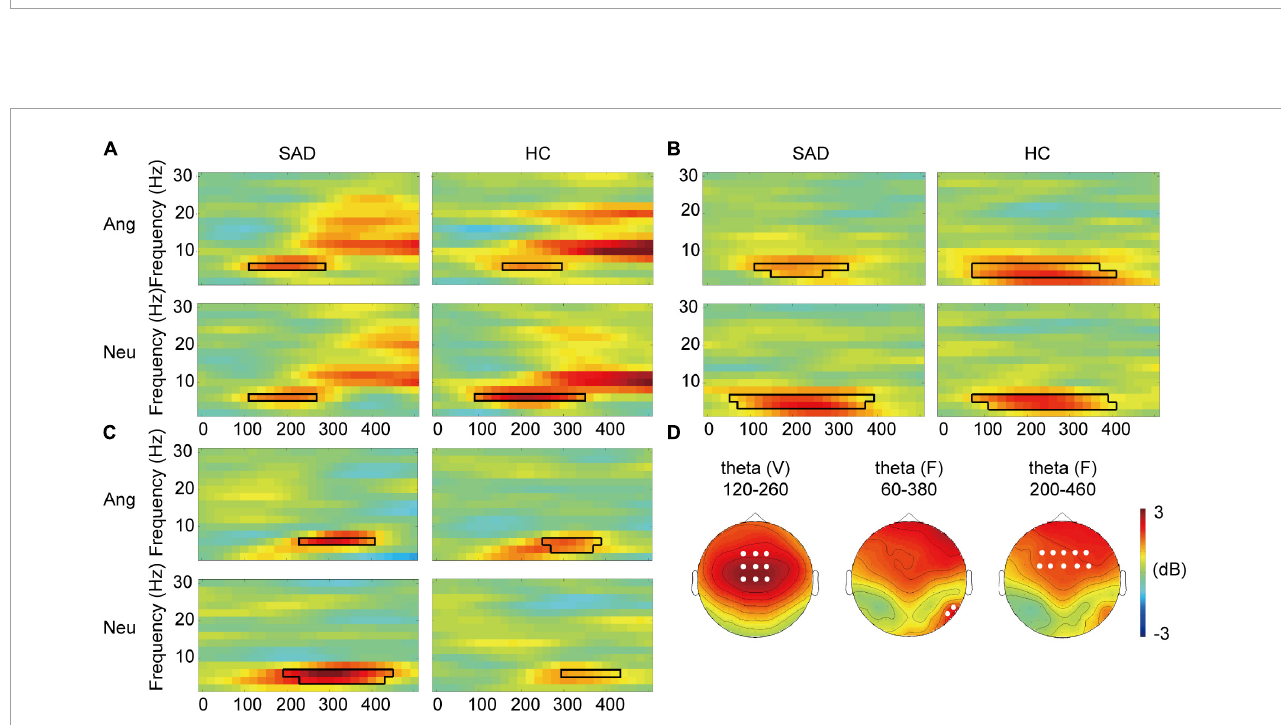
FIGURE3 Cross-modal modulation of TFRs. (A) The grand-averaged TFRs of the difference between voices and bimodal combinations (V-FV) in angry and neutral trials for the SAD and HC groups across fronto-central electrodes. The boxes with black lines indicate the significant temporal-frequency clusters. (B,C) The grand-averaged TFRs of the difference between faces and bimodal combinations (FV-F) across occipital electrodes (B) and across frontal electrodes (C) . The boxes with black lines indicate the significant temporal-frequency clusters. (D) The topographies of voice-sensitive fronto-central theta (left), face-sensitive occipital theta (middle), and face- sensitive frontal theta (right) in neutral trials for the SAD group as examples. The white dots indicate the representative electrodes of the theta